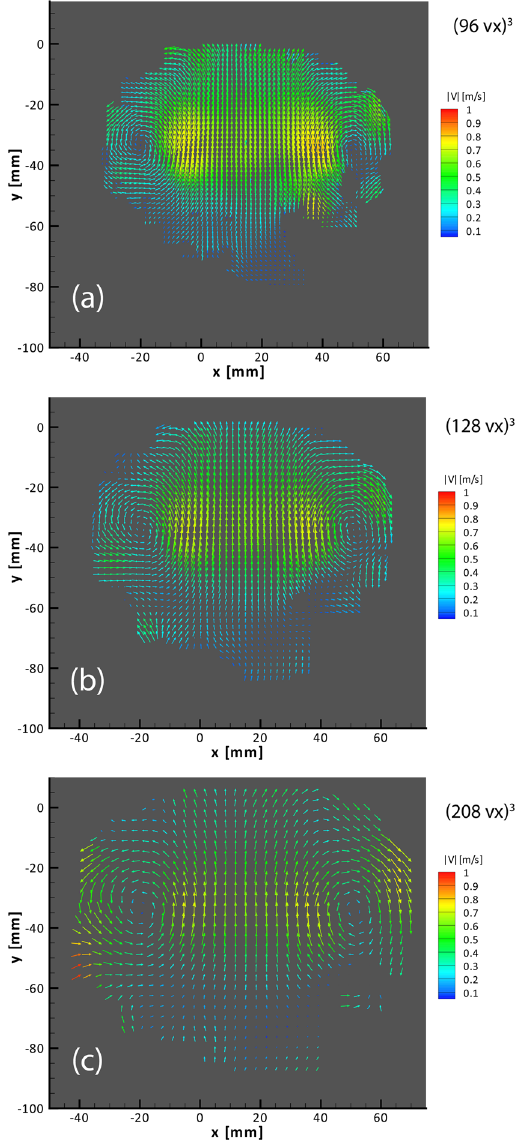
Figure 13. Instantaneous velocity field vectors obtained after direct cross-correlation at the plane z = 0 mm captured with Δ t = 1000 μ s, comparison between 96 ( a ), 128 ( b ), and 208 ( c ) voxel 3 interrogation